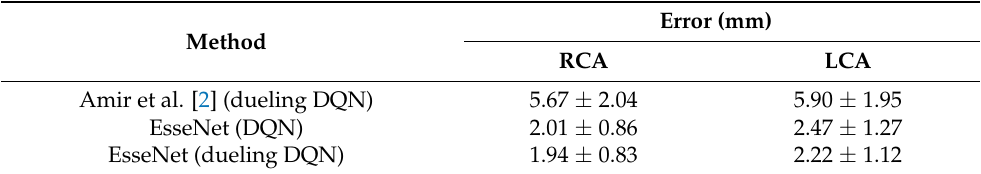
Table 1. Comparison between 3D patch with history [2] and 2.5D patch with history (EsseNet); DQN, deep Q-learning; RCA, right coronary artery; LCA, left coronary artery Error (mm) Method RCA LCA Amir et al. [2] (dueling DQN) 5.67 ± 2.04 5.90 ± 1.95 EsseNet (DQN)